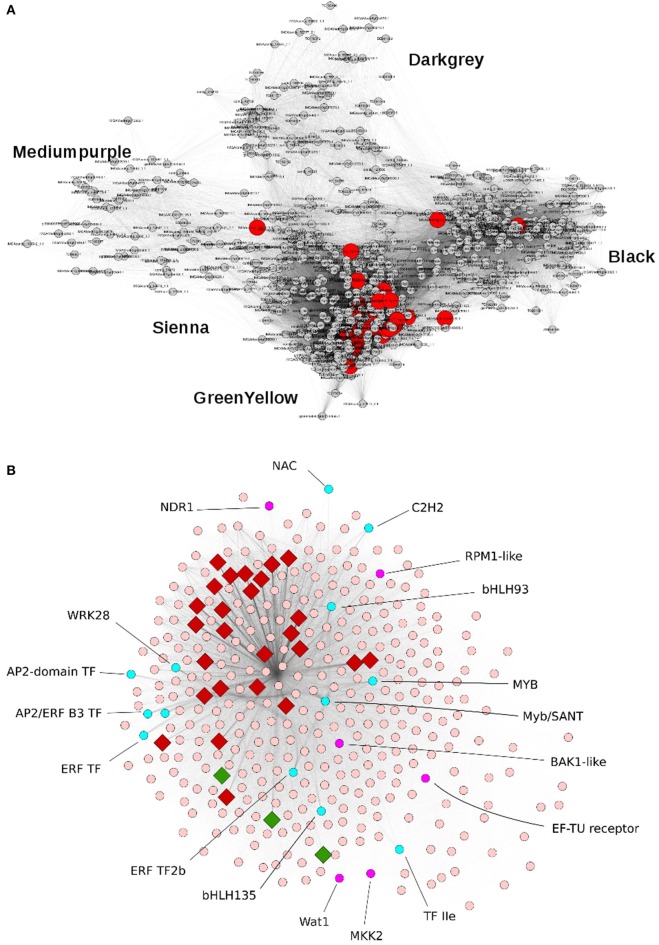
Principal modules of the gene co-expression network associated to inoculation response in the resistant M. truncatula line A17. (A) Representation of the Weighted Gene Co-Expression Network of 794 genes in the resistant line A17. Five modules can be distinguished and are named by color codes. Module Greenyellow contains 369 genes, Black 243 genes, Darkgray 82 genes, Mediumpurple 65 genes, and Sienna 35 genes. Genes differentially expressed after Va V31-2 inoculation are shown in red. (B) Representation of co-expression module Greenyellow which contains 369 genes. A rhombus indicates that the gene is differentially expressed after Va V31-2 inoculation. In red: induced genes, in green: repressed genes, in cyan: transcription factors.